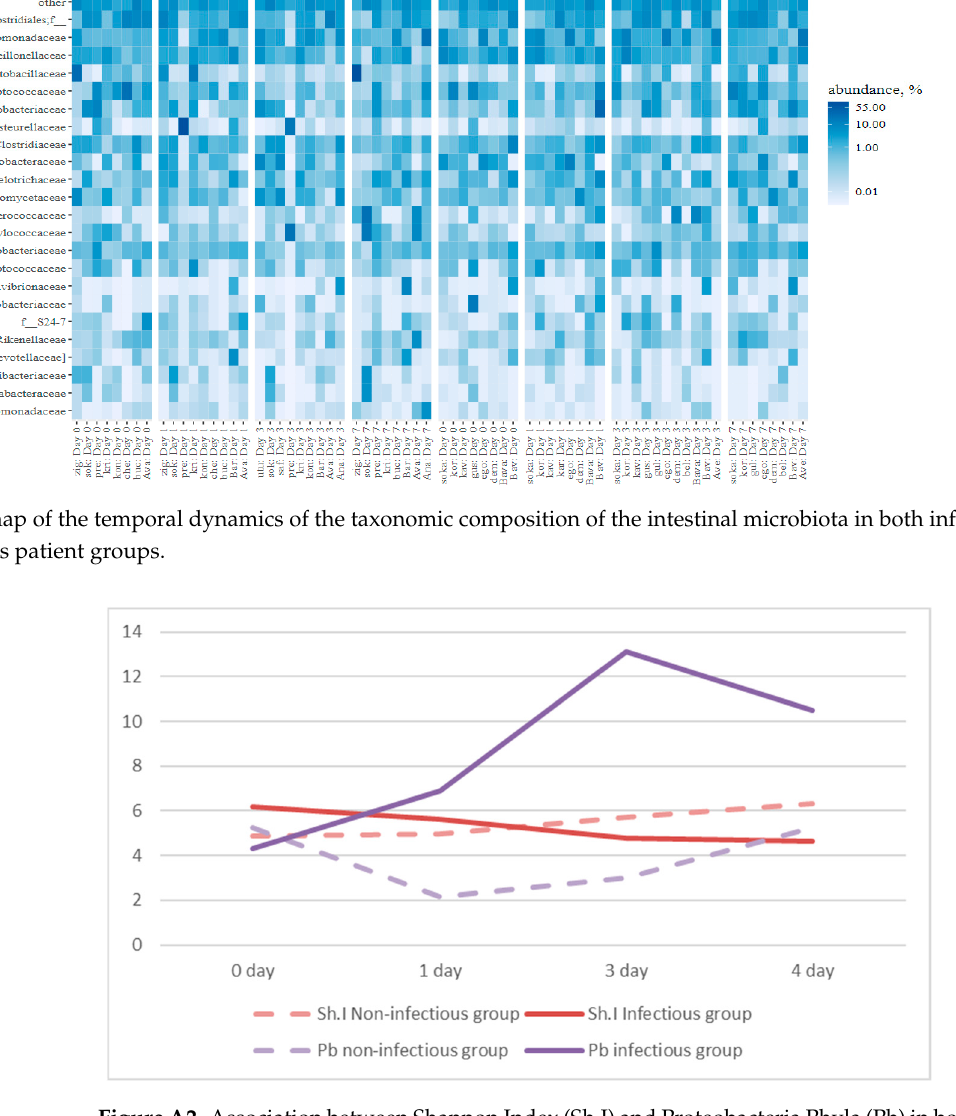
Figure A2. Association between Shannon Index (Sh.I) and Proteobacteria Phyla (Pb) in both Infectious and Non -infectious groups of patients with temporal dynamics. Decrease in Proteobacteria by 1 day in patients in the non-infectious group, most likely with surgical antimicrobial prophylaxis.